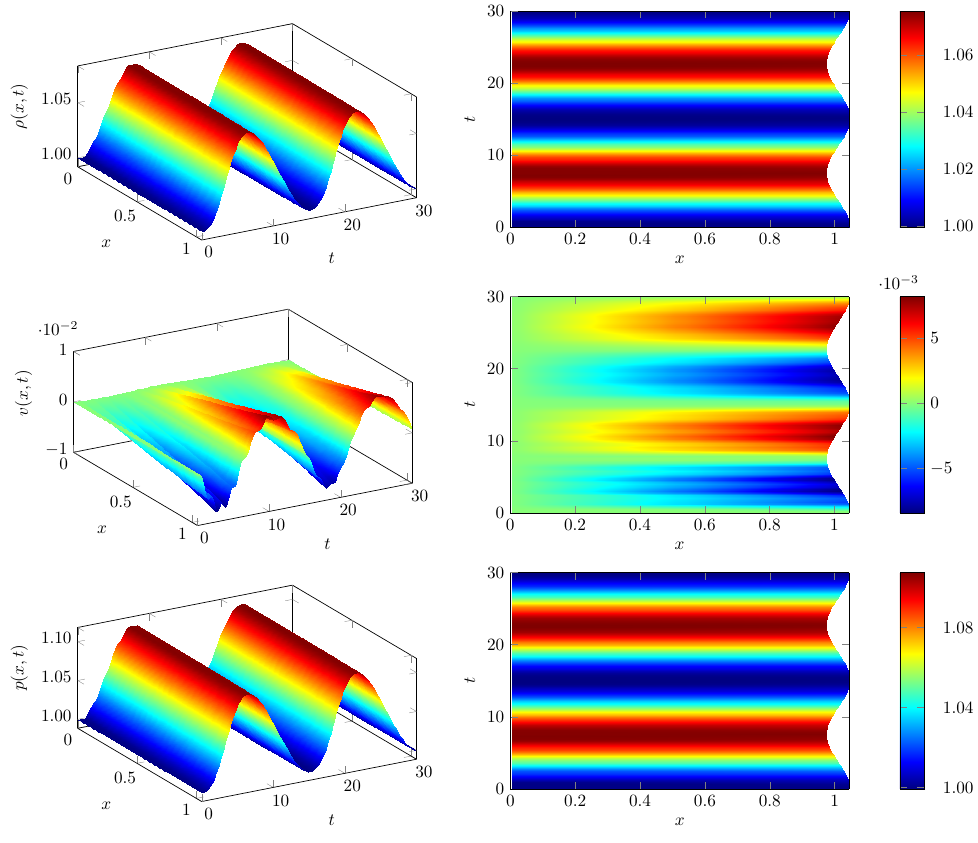
Figure 7. Time evolution of density, velocity and pressure.